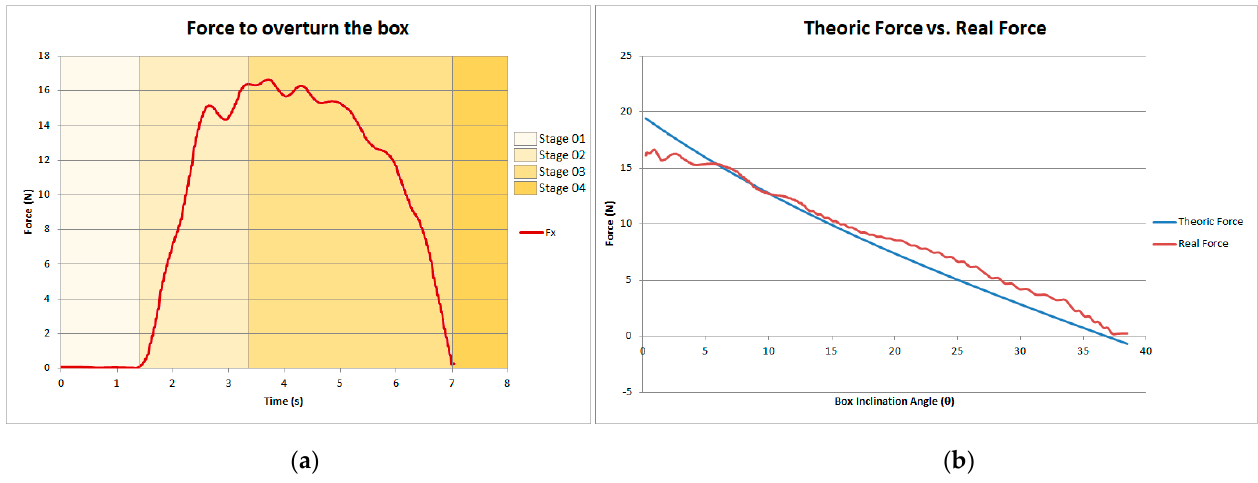
Figure 8. ( a ) Representation of the contact forces during the different stages of movement of the box. ( b ) Comparison of the theoretical force (Equation (3)) and real force detected with the robot sensor.